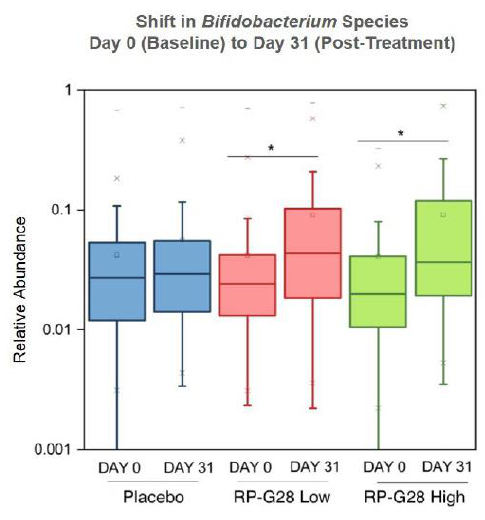
Figure 4. Gut Microbiome Analysis. Table 5. Overall Summary of Treatment-Emergent Adverse Events (Safety